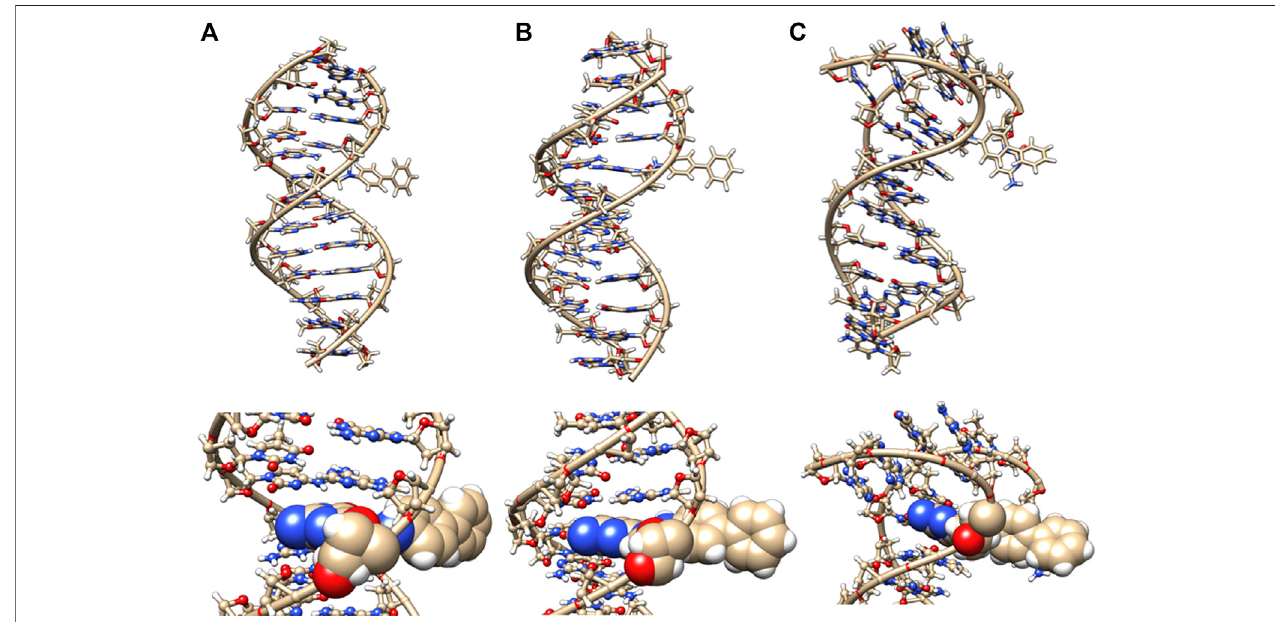
FIGURE11| DNAdodecamerwith4-aminobiphenyldyeadduct. (A) initialminimizedstructure, (B) at100 nsofMDsimulation,and (C) at1 µs.Thebottomrowisa zoomed-in version of the adduct region. Note that the helix has completely unwound from the top at 1 µs of MD.